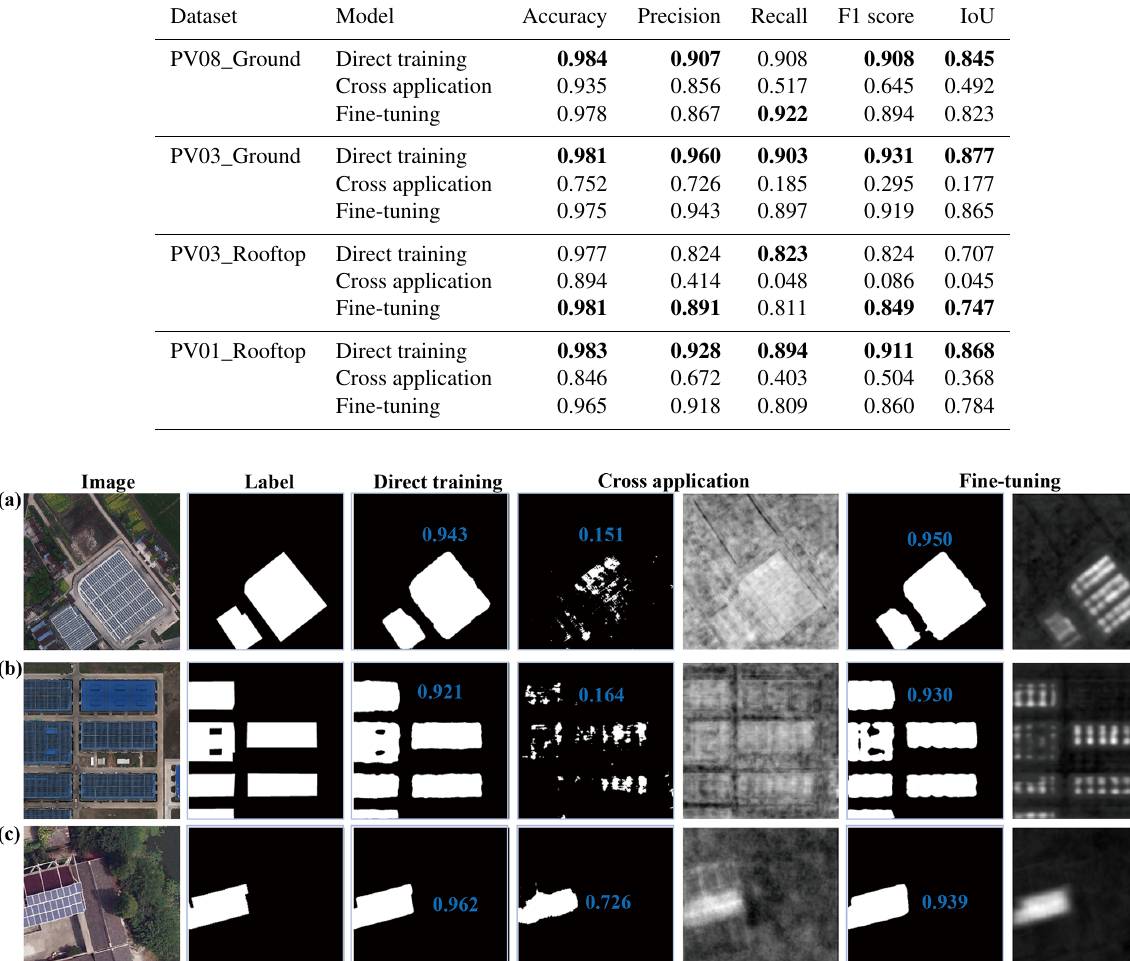
Table 3. Segmentation accuracy of DeepLab v3 + trained by different strategies. The best values are marked in bold.